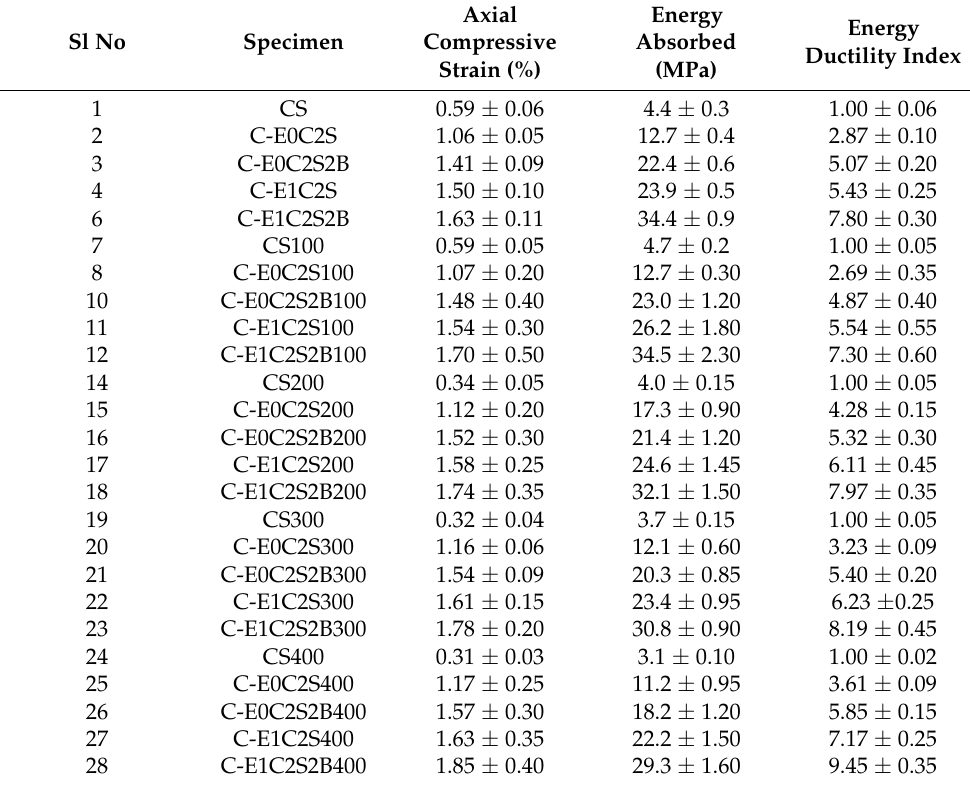
Table 7. Energy ductility index of confined and unconfined specimens subjected to elevated